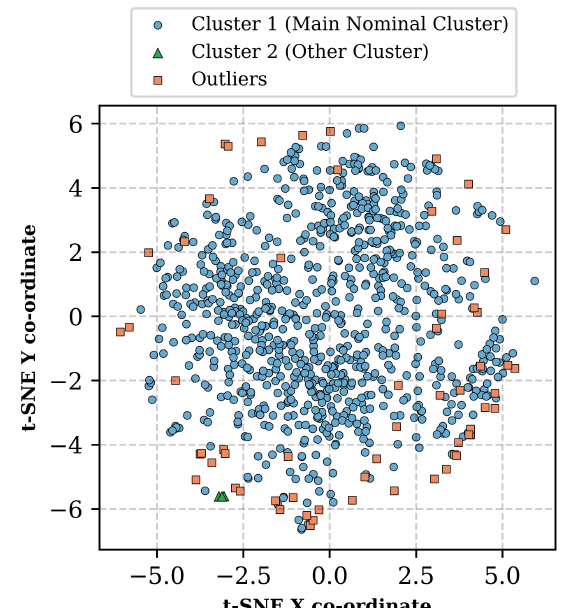
Figure 5. Overall results after applying the HDBSCAN algorithm on the feature vector.